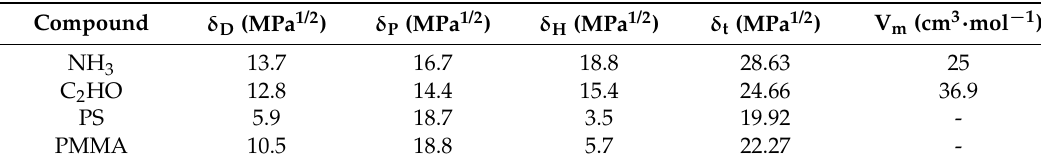
Table 3. Hansen’s solubility parameters of the organic compounds possibly interacting in the vQRS using δ t = ( δ D2 + δ P2 + δ H2 ) 1/2 .